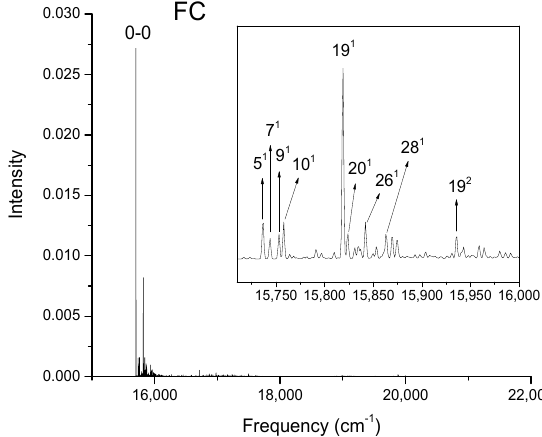
Figure 4. Calculated vibronic absorption spectrum of chlorophyll a using the B3LYP functional and 6-31G(d) basis set, including the FC contribution. The inset magnifies the 16,395–16,550 cm − 1 region of the spectrum associated with assigned vibronic transitions.